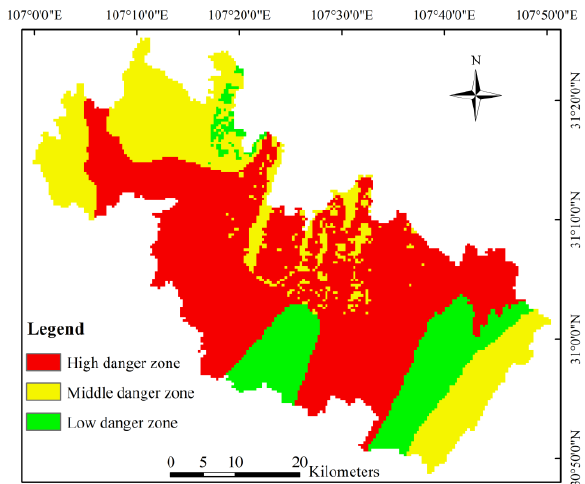
Figure 9. Potential hazard zoning in Dachuan